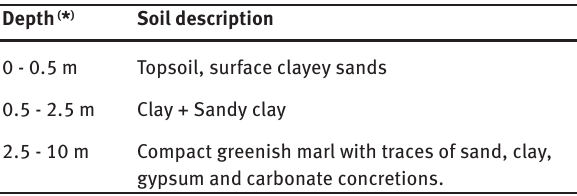
Table 1: Lithology of the